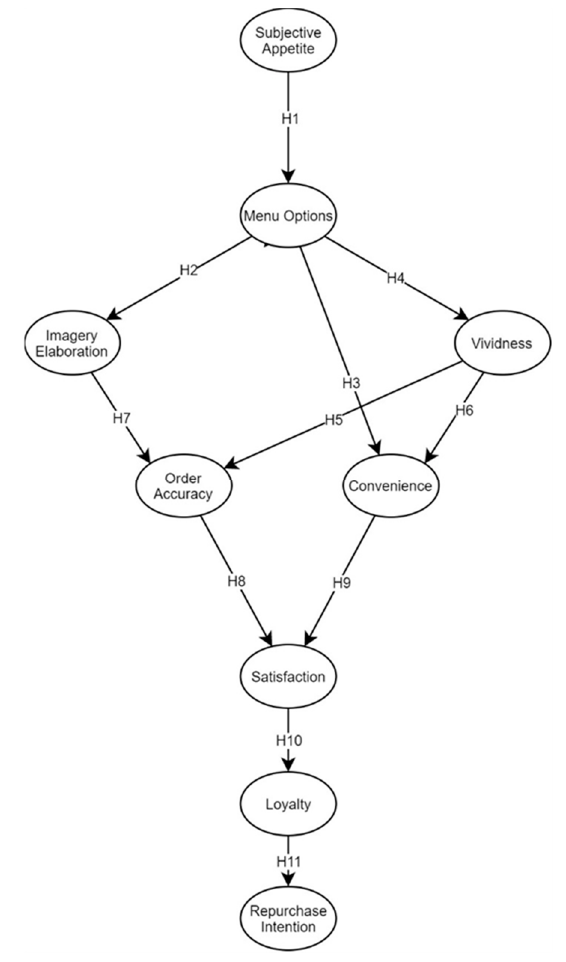
Figure 1. Theoretical research framework. Meanwhile, the entire area of food intake, choice, motivation, and preference is covered by subjective appetite [17]. The sight of preferred or less preferred is sufficient enough to influ- ence the customer’s desire to eat [18]. Consequently, a study by Schulte-Mecklenbeck et al. [19] stated that customers who are aware of their food options commonly ignore complex infor- mation on the menu when ordering. Thus, we hypothesized that: Hypothesis 1 (H1). Subjective appetite of customers had a significant direct effect on the menu options offered by the